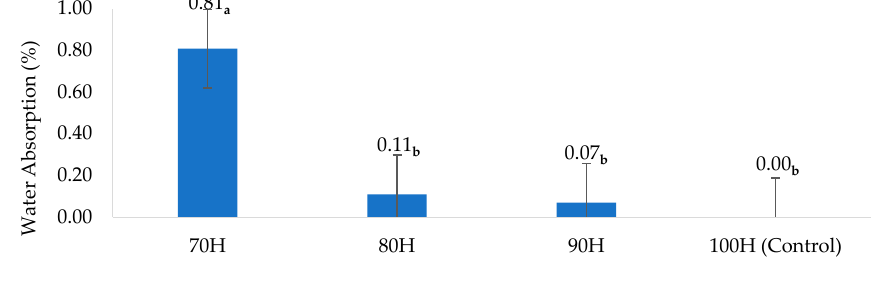
Different Ratios of High-Density Polyethylene (HDPE) and Wood Powder ( C ) The different alphabets (a, and b) displayed beside the average values show significant differences among the parameters Figure 3. Average water absorption for ( A ) seaweed-based adhesive particleboard, ( B ) starch-based adhesive particleboard, ( C ) WPC. In general, the water absorption test is a measurement method to indicate the per- centage of water diffused inside the wood composite component. The water absorption rate is dependent on the density and water diffusivity of the material itself [37]. Water